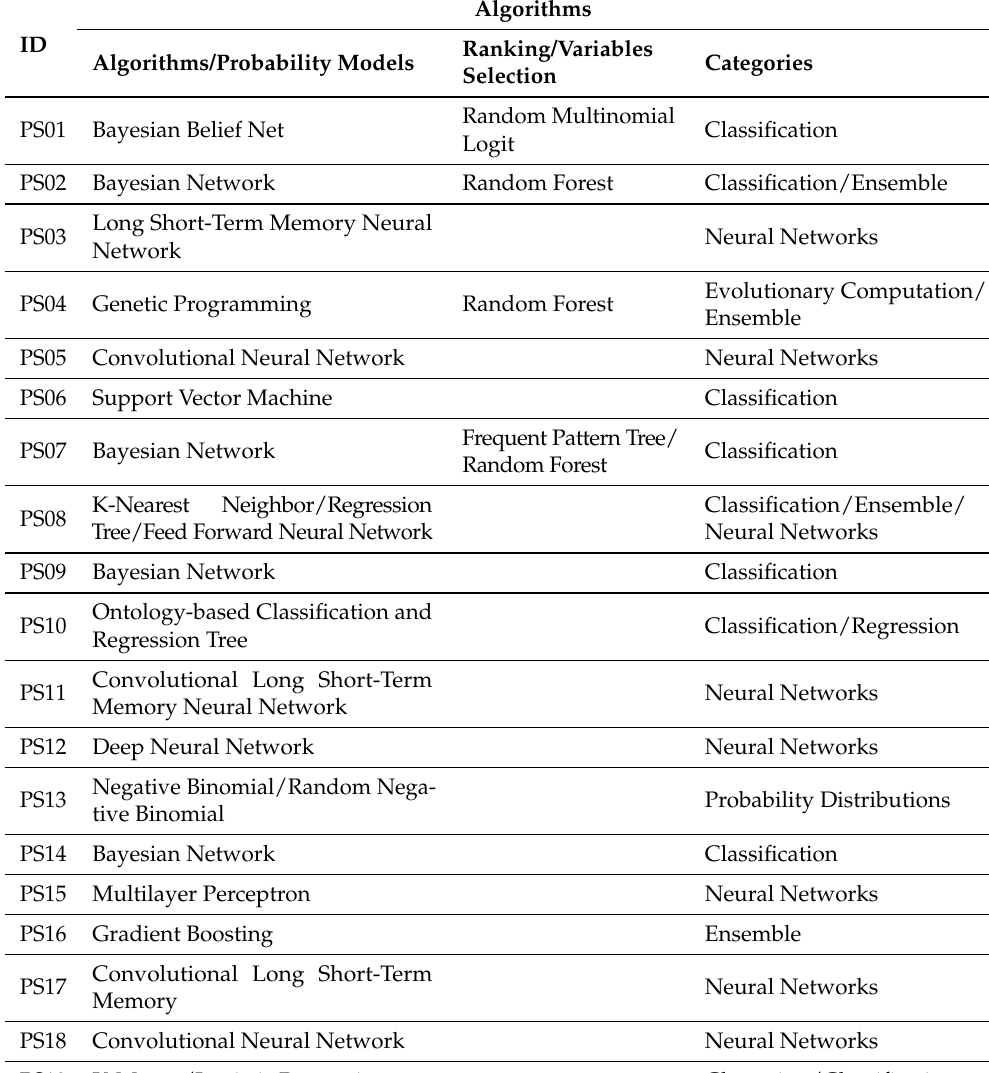
Table 3. Classification of algorithms by